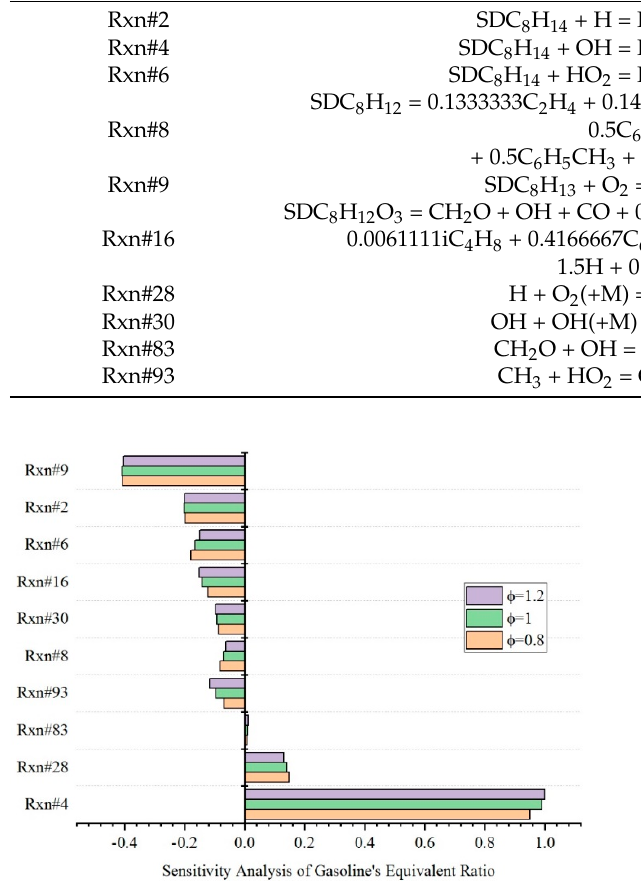
Figure 6. Effects of equivalence ratio on the chemical reaction path of kerosene (T = 800 K; P = 20 Table 4. Lists of the important reactions of gasoline. bar; black: Φ = 0.8; red: Φ = 1; blue: Φ = 1.2). Table 4. Lists of the important reactions of gasoline.